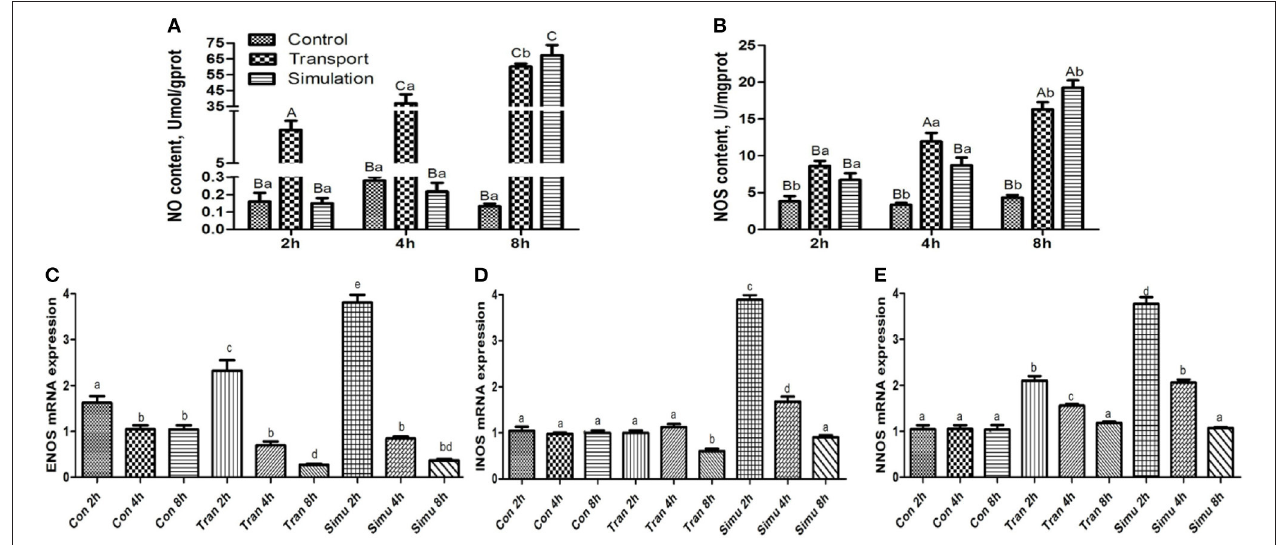
FIGURE 4 | Effect of transport stress on NO metabolism (NO- NOS system) in the heart of newborn chicks. (A) NO content, (B) NOS activity, (C) the expression of ENOS mRNA at 2, 4, and 8h, (D) the expression of INOS mRNA at 2, 4, and 8h, and (E) the expression of NNOS mRNA at 2,4, and 8h. Data are presented as the mean ± SD. Compared with the control: Row (Column) with different capital letter superscripts indicates an extremely significant difference ( p < 0.01); Row (Column) with different small letter superscripts indicate significant difference ( p < 0.05); Row (Column) with different small letter superscripts indicate no significant difference ( p > 0.05). Con, the control groups; Tran, the transport groups; Simu, the simulation transport groups; mgprot, milligram of